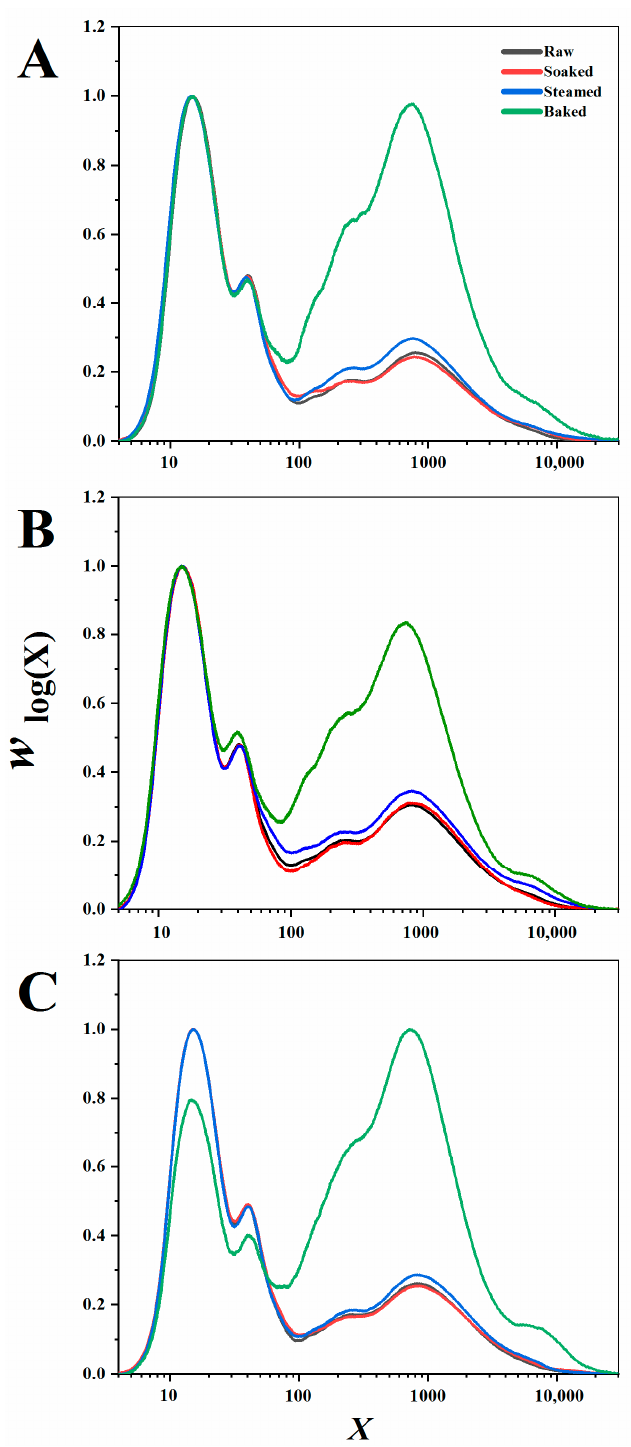
Figure 2. Chain length distributions of raw and different processed millet starch (soaked, steamed, and baked, respectively). ( A – C ) represents M1, M2, M3, respectively. X represented the DP value of an individual chain.